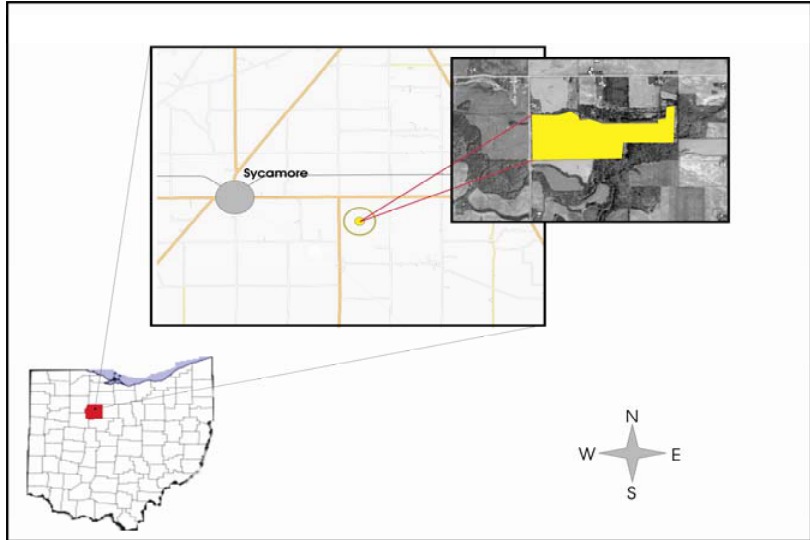
Figure 1. Study Area location and regional